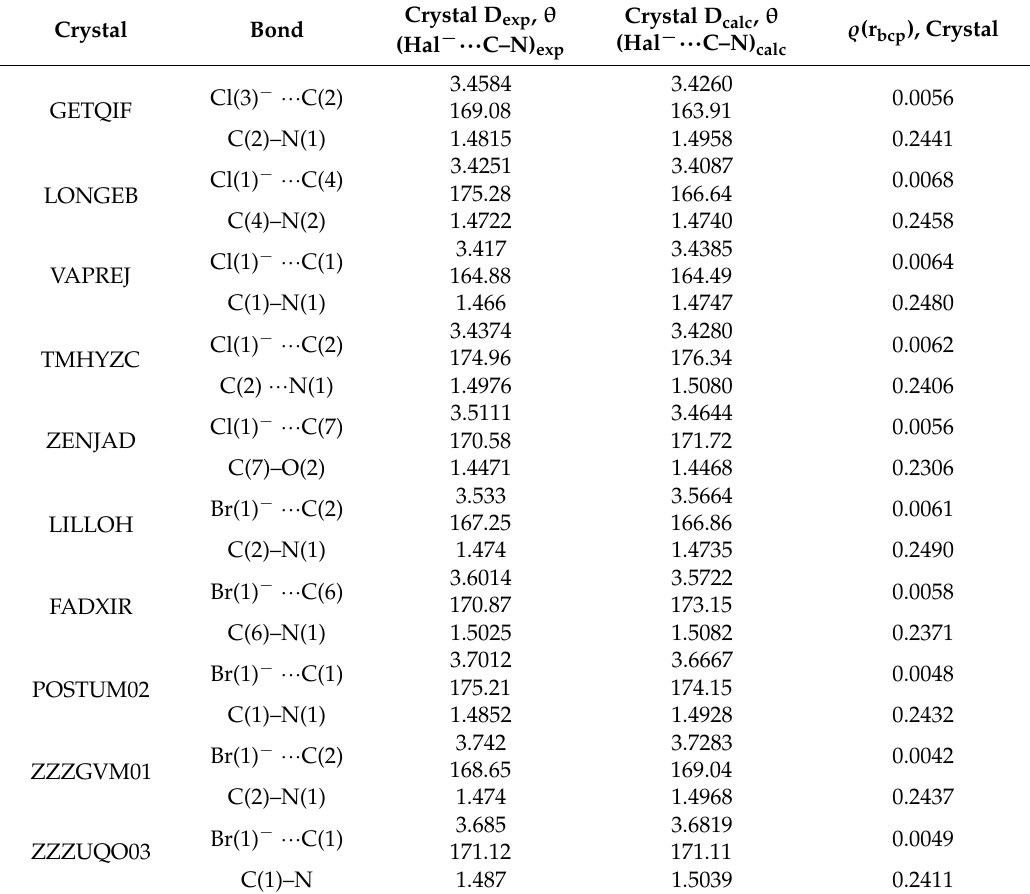
Table 1. Experimental and calculated tetrel and C–Y bond lengths, D (Å), angles Hal − ··· C–Y, θ and calculated electron density, (cid:36) (r bcp ) (a.u.) at bond critical points for considered crystals.